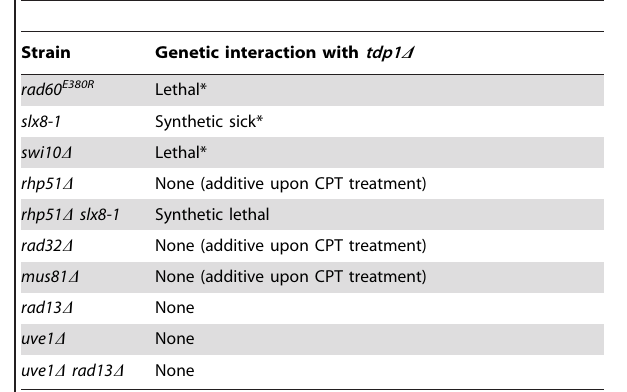
Table 1. Summary of genetic interactions of tdp1 D cells.